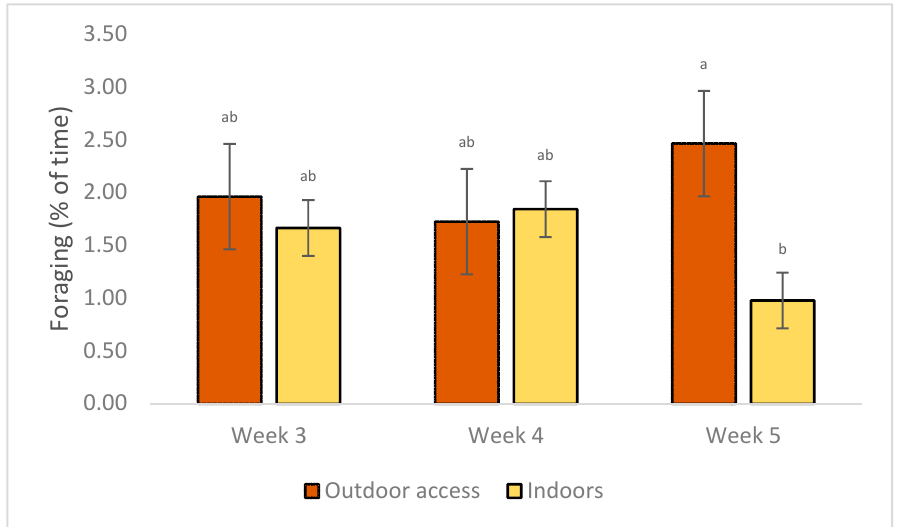
Figure 3. LS Means of the effects of system × week on foraging of commercial-line broilers. Different superscript letters indicate statistically significant differences (Tukey’s HSD test; p ≤ 0.05).